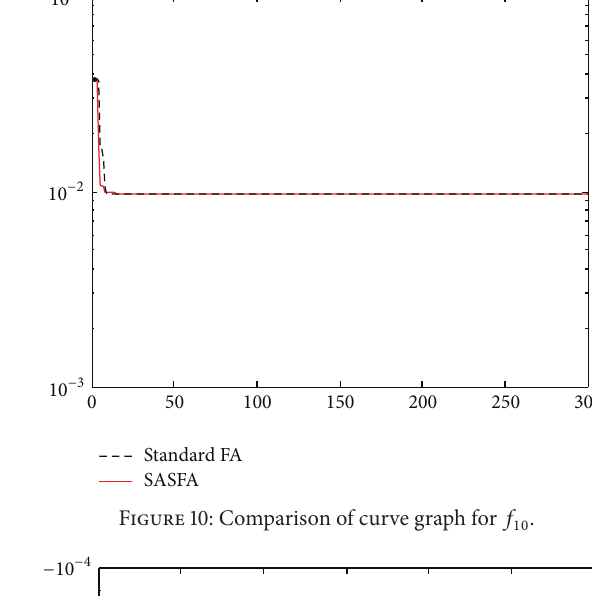
Figure 10: Comparison of curve graph for 𝑓 10 .